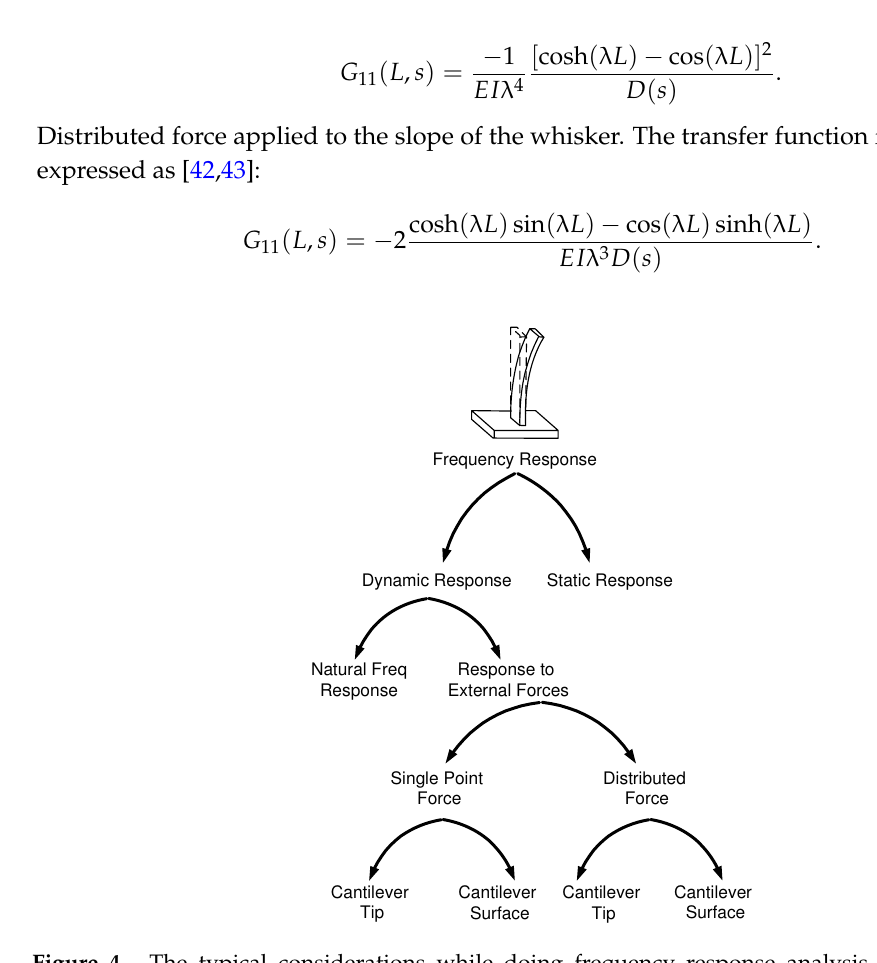
Figure 4. The typical considerations while doing frequency response analysis of a cantilever beam-based sensor. The natural frequency of a cantilever beam changes depending on type of loading and boundary